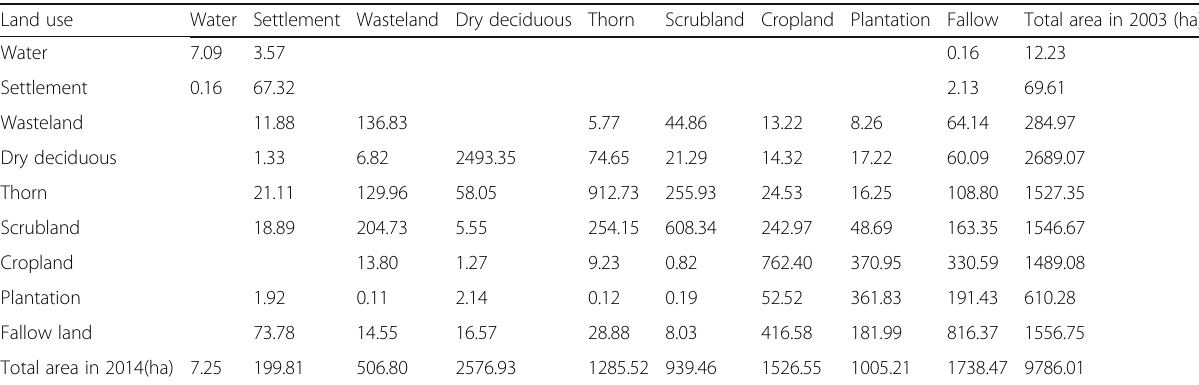
Table 7 Land use change matrix (2003 –